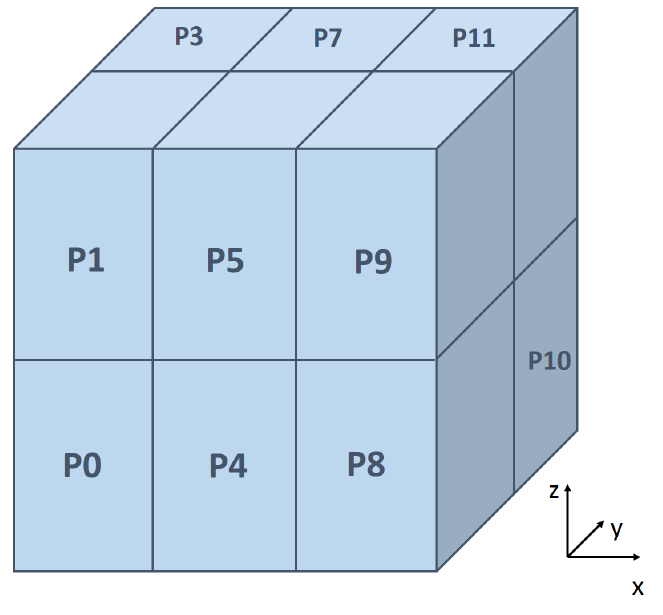
Figure 1. A schematic illustration of the domain decomposition technique.